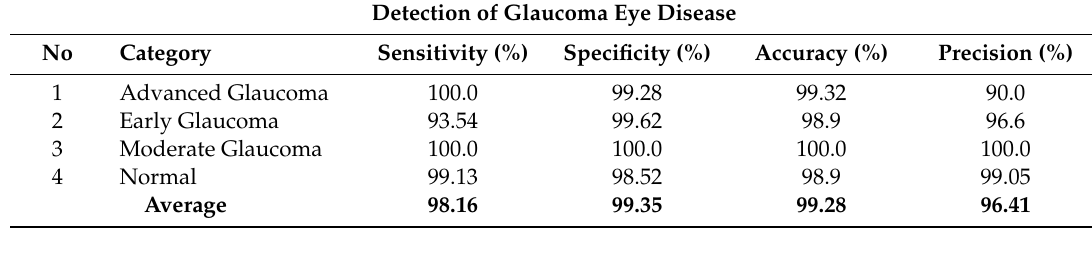
Table 4. Computed Values (%) of Statistical Measures on Testing Dataset.